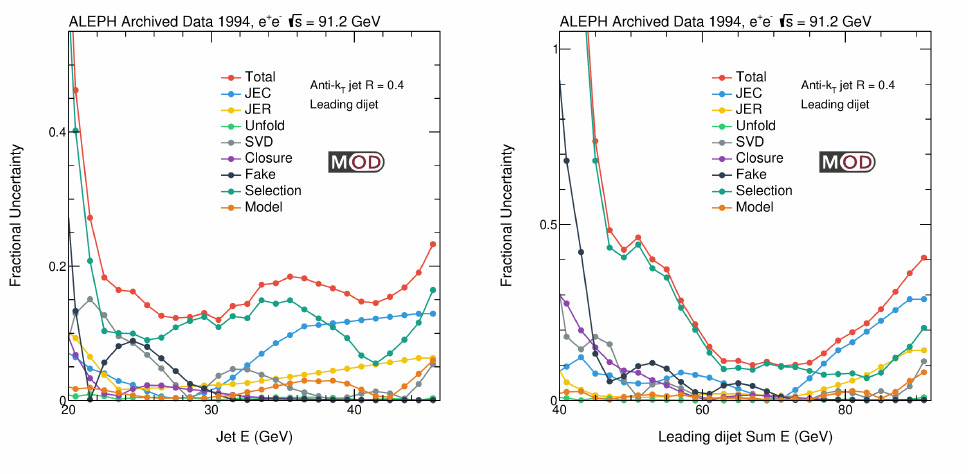
Figure 7 . Summary of the size of relative systematic uncertainty from different sources for each of the two jet E in leading dijet (left) and leading dijet total energy